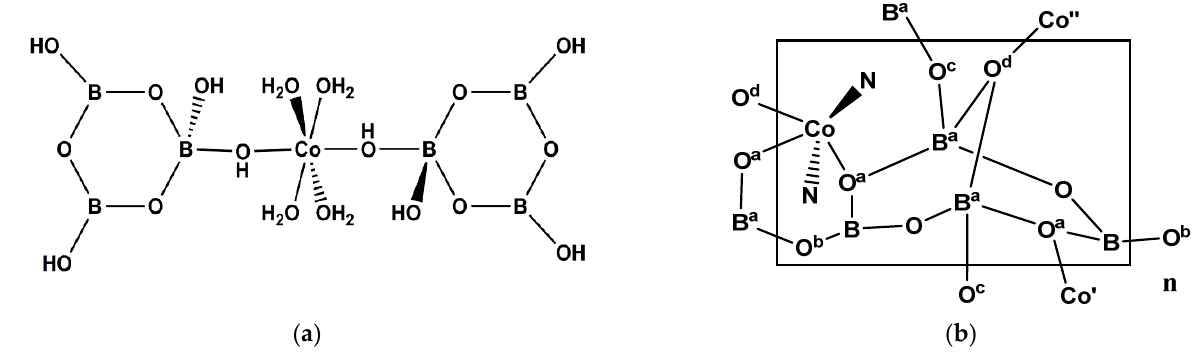
Figure 3. ( a ) The structure of [Co(H 2 O) 4 {B 3 O 3 (OH) 4 } 2 ] ( 7 ), and ( b ) the building unit of [Co(dap) 0.5 (dap’) 0.5 {B 4 O 7 }] n ( 8 ). A diagram of the structure of [Co(dap) 0.5 (dap’) 0.5 {B 4 O 7 }] n ( 8 ) [8] (Figure 3b) shows a